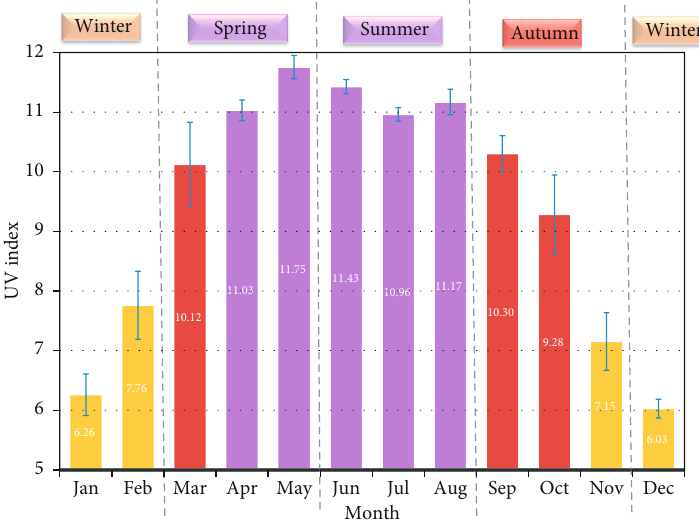
Figure 5: Monthly mean UVI on the campus of KAU during the study period.